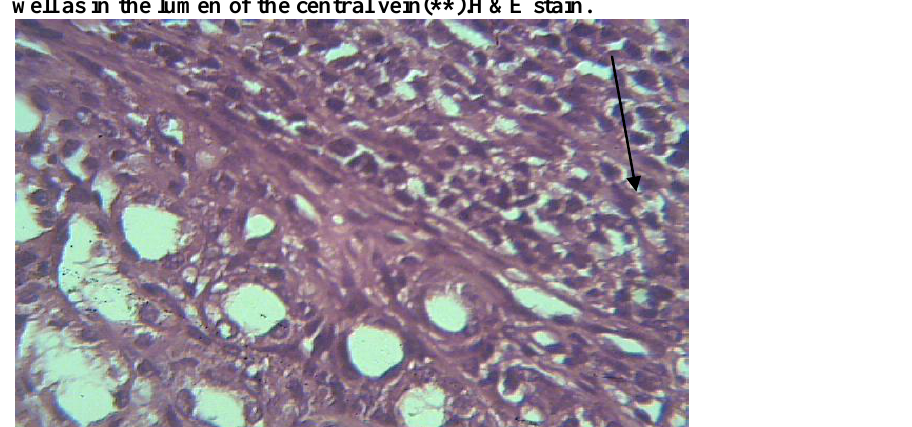
Fig 5: Histological section of the mice kidney at 2 weeks post immunization with HK-CA+FIA showed large amount of mononuclear cells infiltration and in the capsular layer( ) H&E stain.